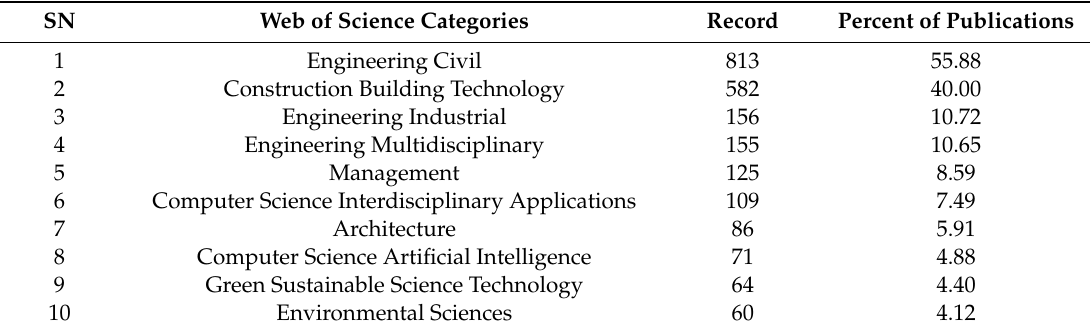
Table 5. Top 10 productive WoS subject categories.